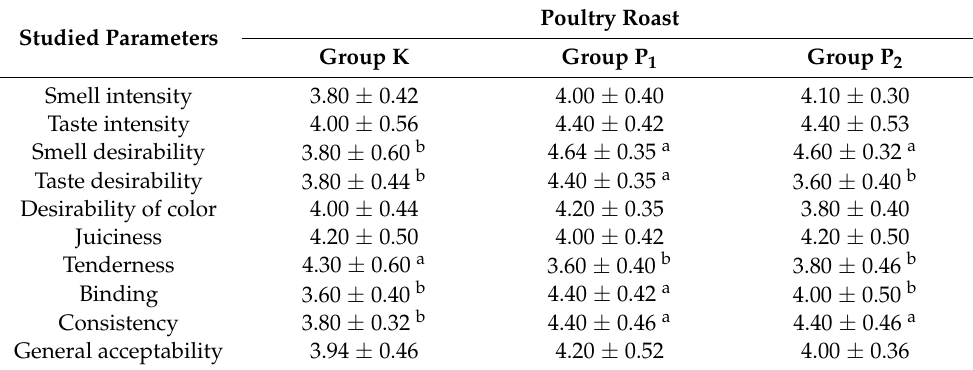
Table 5. Impact of enrichment with seeds, flour, and hemp oil on the sensory characteristics of poultry roast (points). Poultry Roast Studied Parameters Group K Group P 1 Group P 2 Smell intensity 3.80 ± 0.42 4.00 ± 0.40 4.10 ±